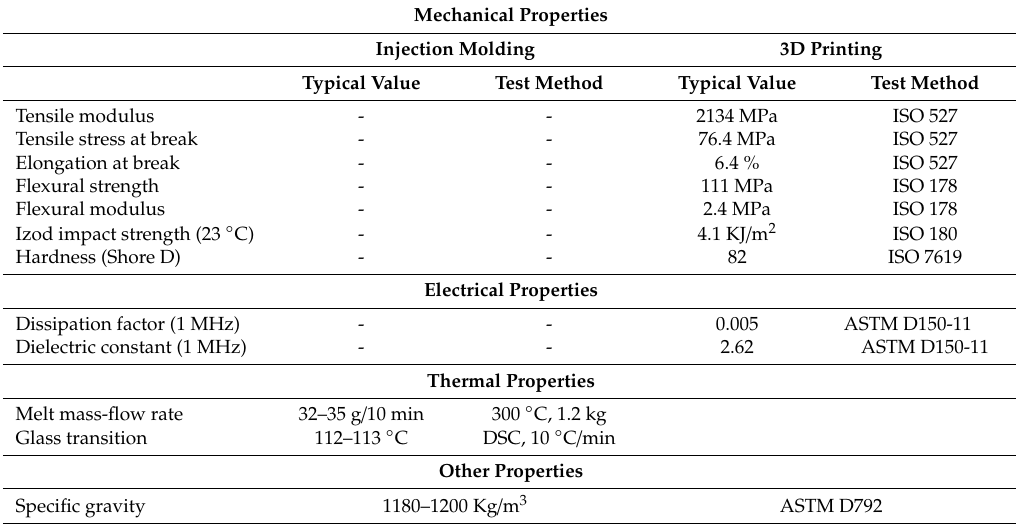
Table 1. Polycarbonate properties.